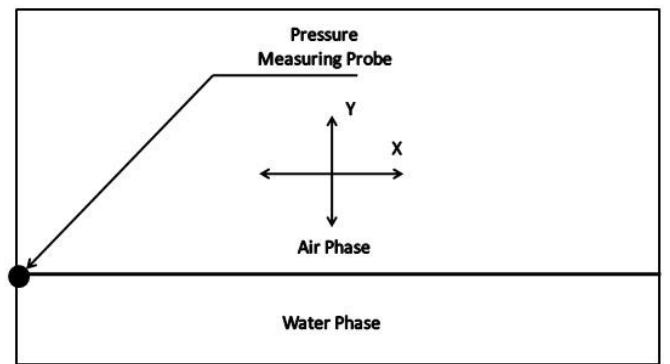
Figure 1. Computational domain employed in the study.